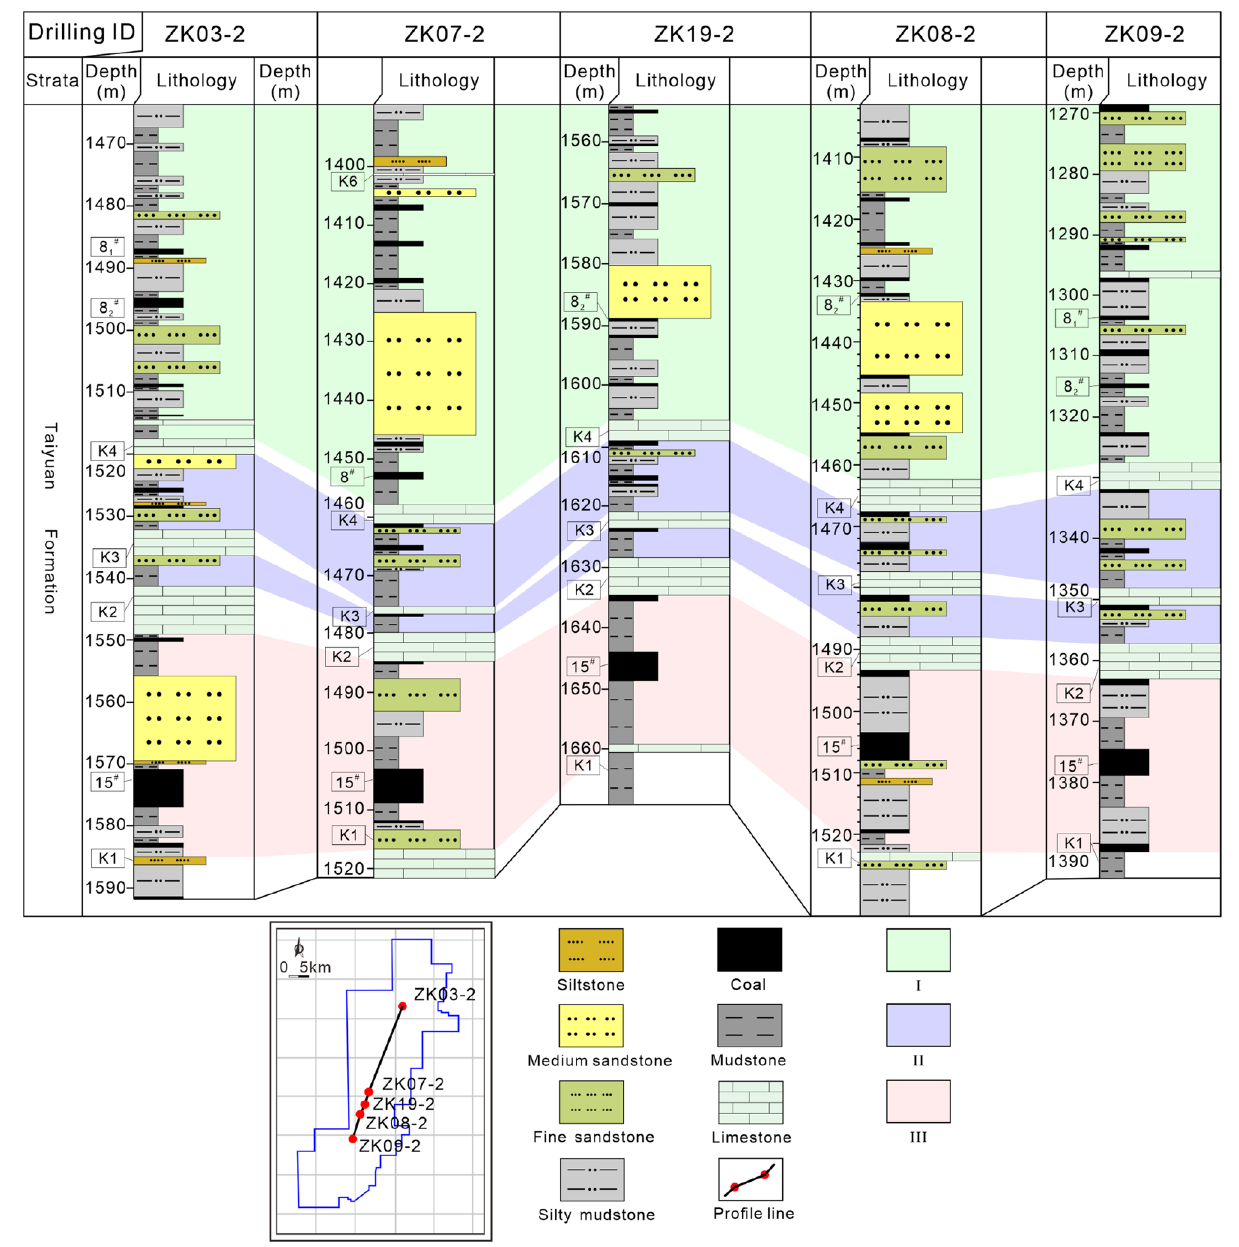
Figure 11. Spatial distribution characteristics of combinations I, II, and III in the study area. K1–K7 are the signature strata of Taiyuan Formation, and 8 1# , 8 2# , 15 # are coal seams. I–III represent combinations